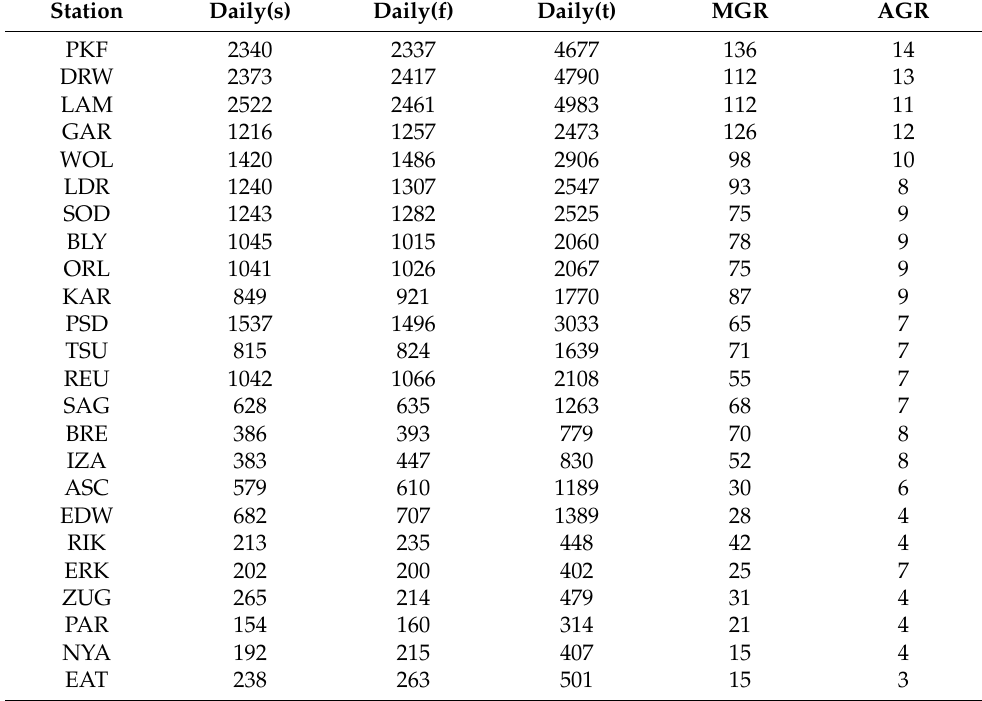
Table 1. Irregular measurement sampling characteristics or the data abundance for calculating global AGR TCCON . Daily(s) represents the observation days per month at a station used for calculating µ XCO 2(m,y-12) term in Equation 4. Daily(f) has similar meaning but for the same Equation. Daily(t) is the sum of (s) and (f) observation days. MGR and AGR denote the total number of station-wise MGRs and AGRs, respectively. Station Daily(s)